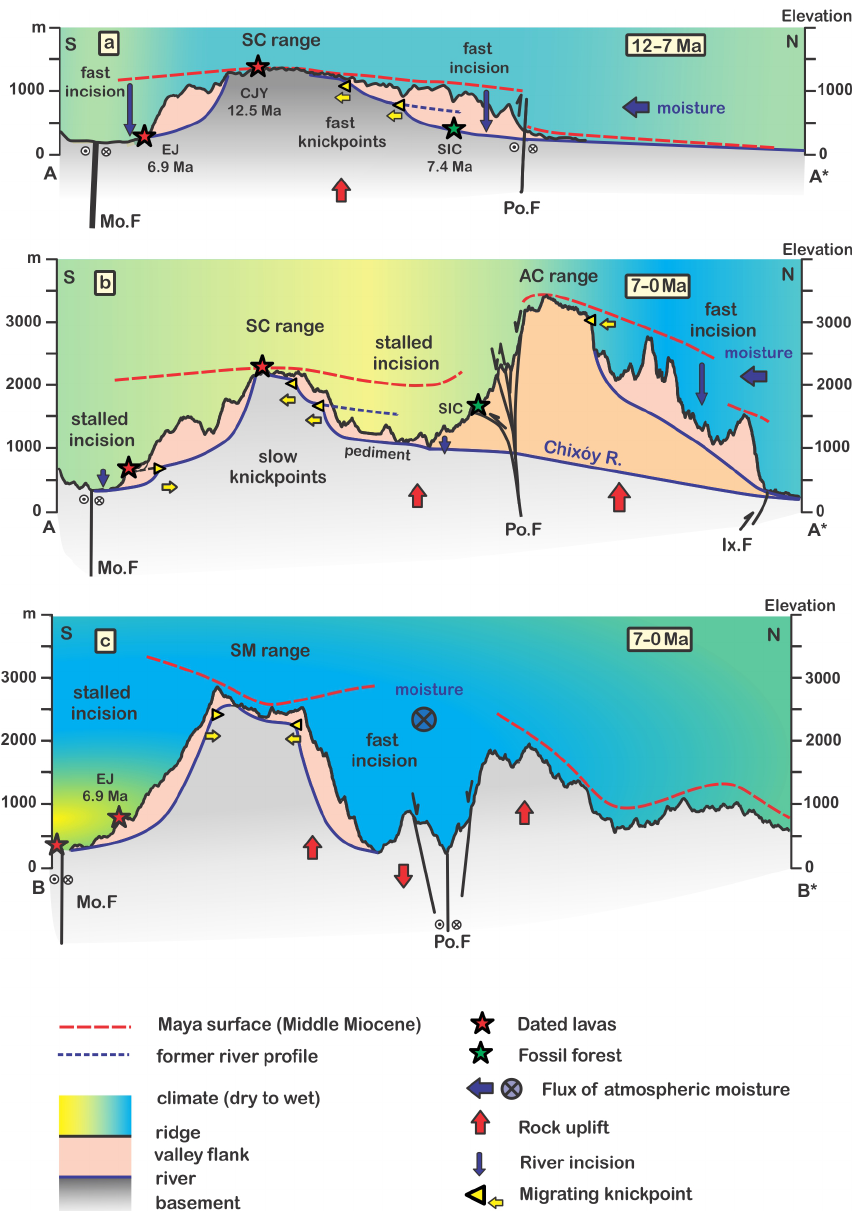
Figure 16. Development of the central ranges of Guatemala. Along profiles A-A* and B-B* (see Fig. 13a for location) (AC: Altos de Cuchumatanes; EJ: El Jute; Mo.F: Motagua Fault; Po.F: Polochic Fault; SC: Sierra de Chuacús; SIC: fossil forest of Sicaché; SM: Sierra de las